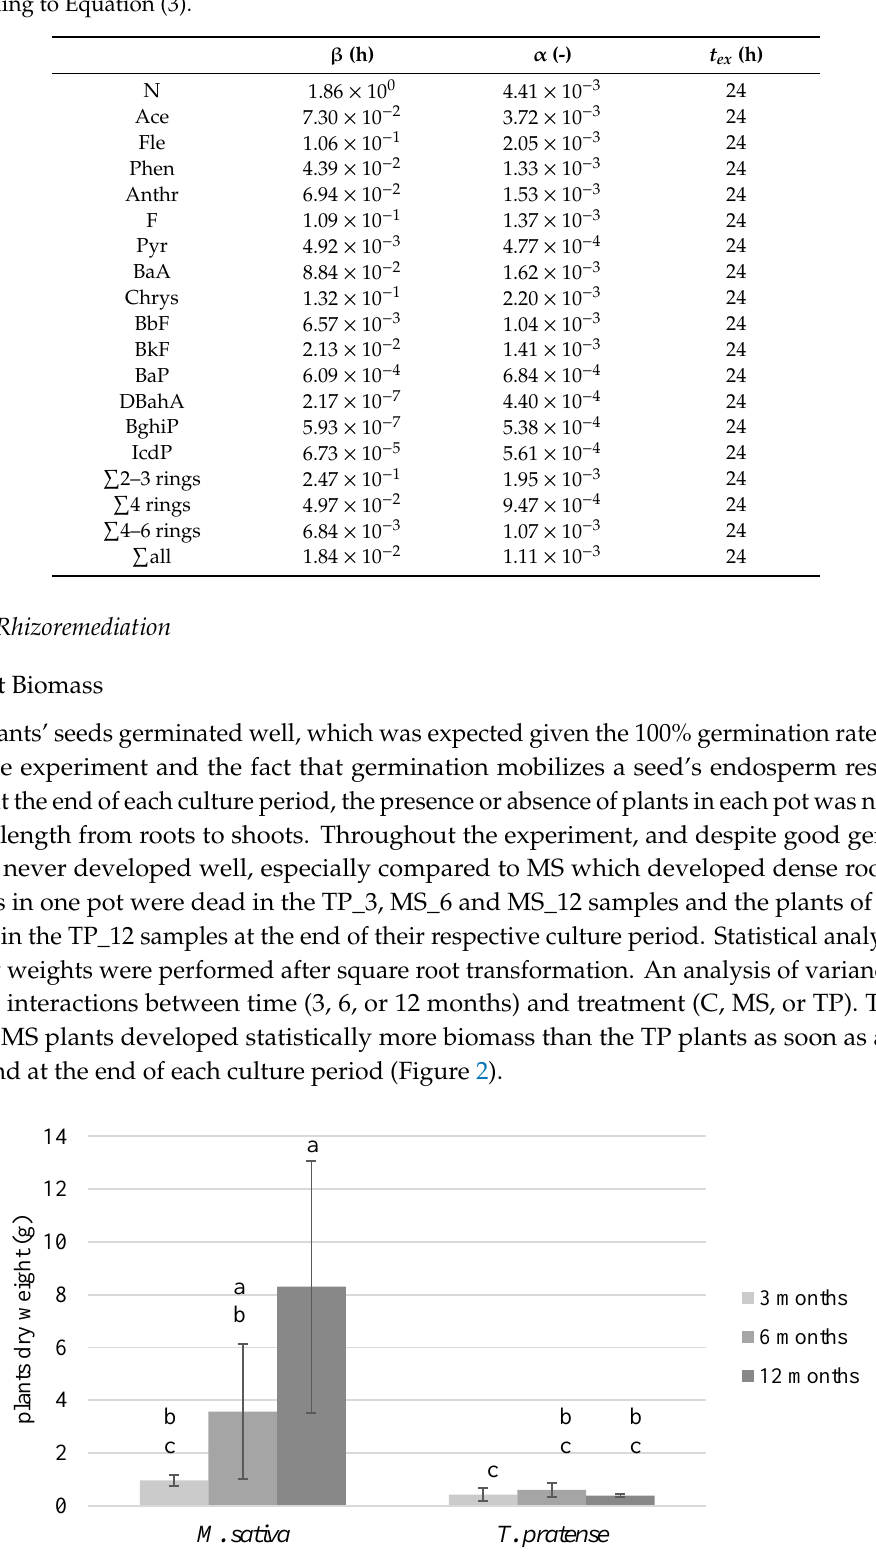
Figure 2. Plants dry weight (biomass) after each culture period. Within each group, bars that share the same letter are not significantly different ( p > 0.05). The values are means ± confidence interval ( α = 5%; n = 5; n = 4 for TP_3, MS_6 and MS_12; and n = 2 for TP_12).